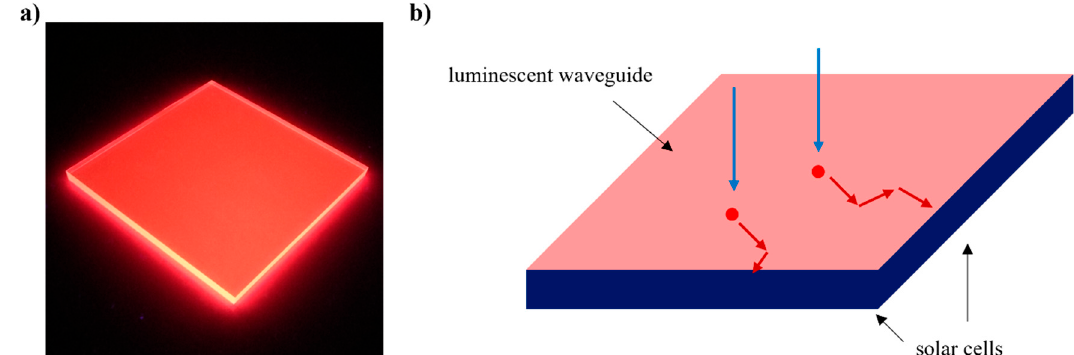
Figure 1. ( a ) A picture of luminescent waveguide under ultraviolet (UV) light, showing highly intensive luminescent light from the edge of the luminescent waveguide, and ( b ) operational mechanism of LSCs. Incident photons are absorbed and converted to luminescent photons, which transport to the edges of the luminescent waveguide through successive TIR and are delivered to solar cells.